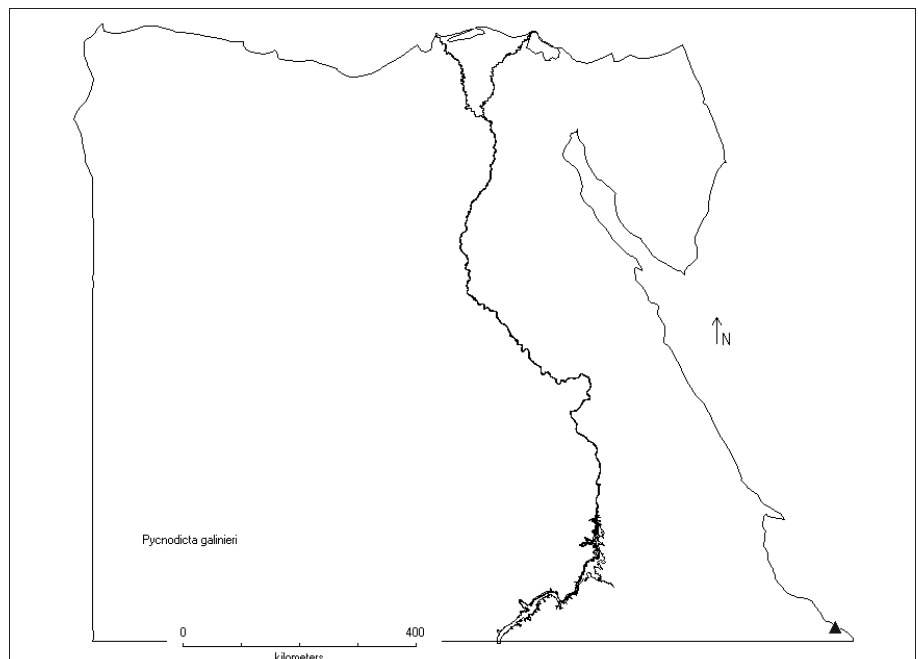
Figure 16. Map of Egypt showing the local distribution of Pycnodictya galinieri